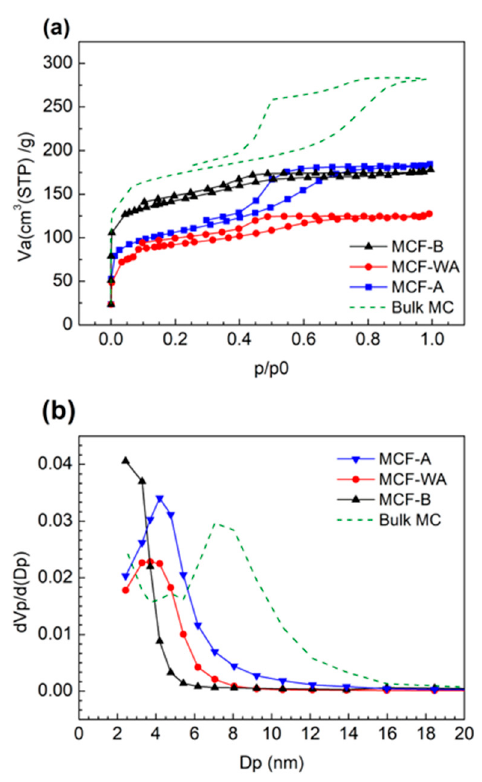
Figure 1. Nitrogen sorption isotherms ( a ) and the corresponding pore distributions, ( b ) of different MCF samples and bulk MC as a reference sample. Table 1. Summary of physical properties of MC fibers (MCFs) and bulk mesoporous carbon (MC). Pore Diameter